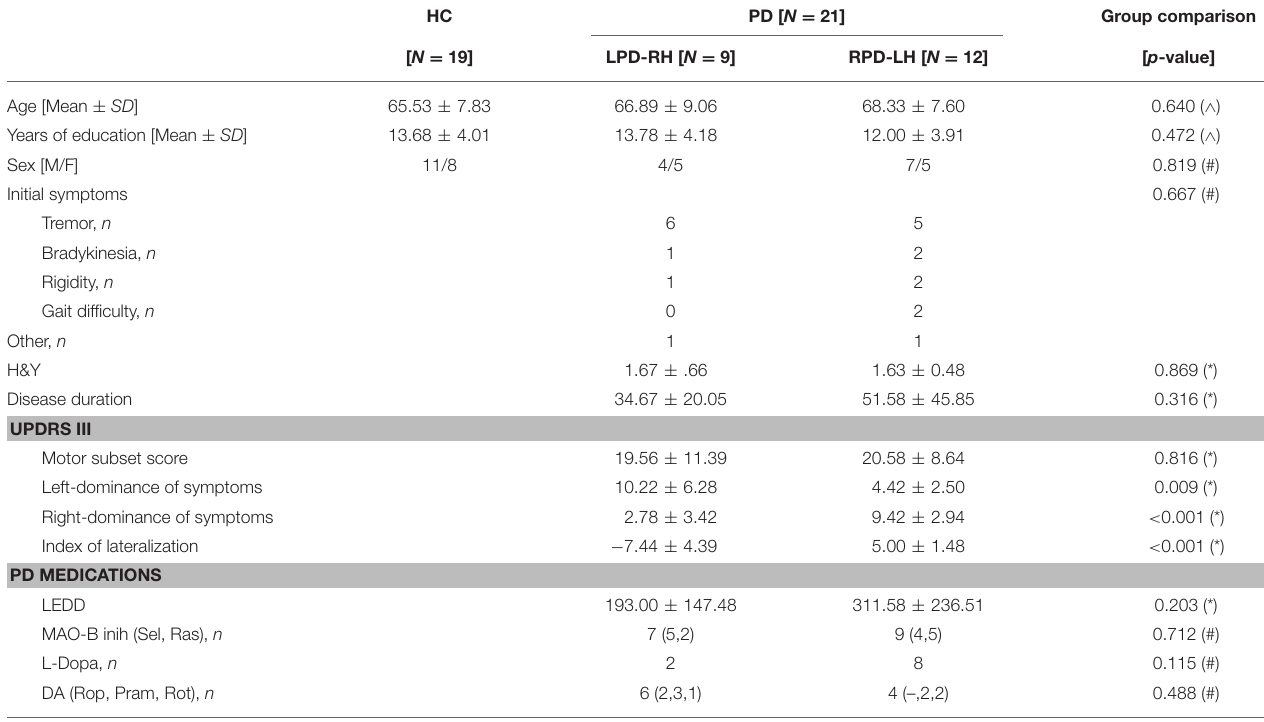
TABLE 1 | Demographic and clinical characteristics of HC (healthy controls) and PD (Parkinson’s disease) groups of